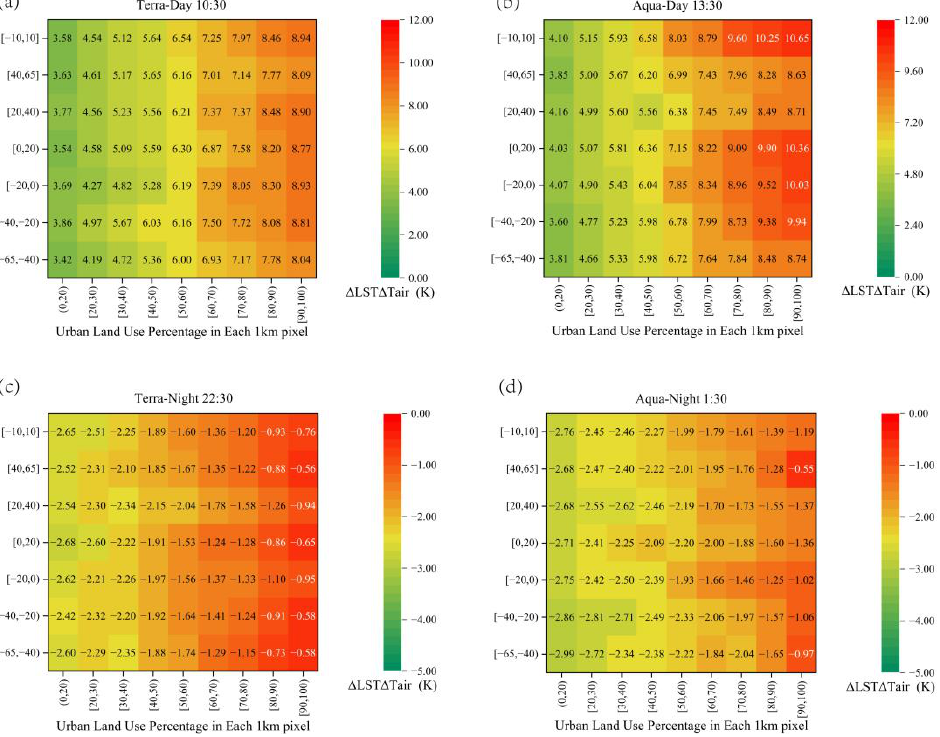
Figure 6. Heat map of ∆ LST ∆ T distribution for each SZA group at different land-use intensity percentage, for the four overpass times. The abscissa represents the land-use intensity percentage in a 1 km grid cell, and the ordinate represents the SZA group. Specifically, the subfigures ( a – d ) illustrate the distributions of ∆ LST ∆ T for each SZA group at different land-use intensity percentages during satellite overpass at 10:30, 13:30, 22:30, and 01:30, respectively.